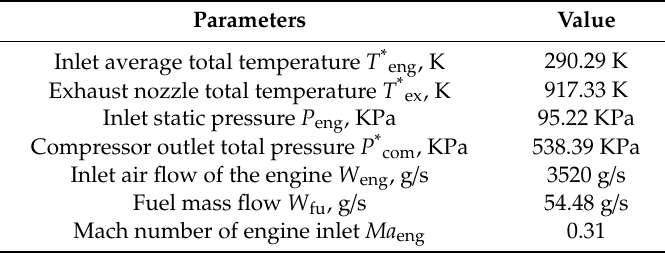
Table 3. Engine performance parameters [26].